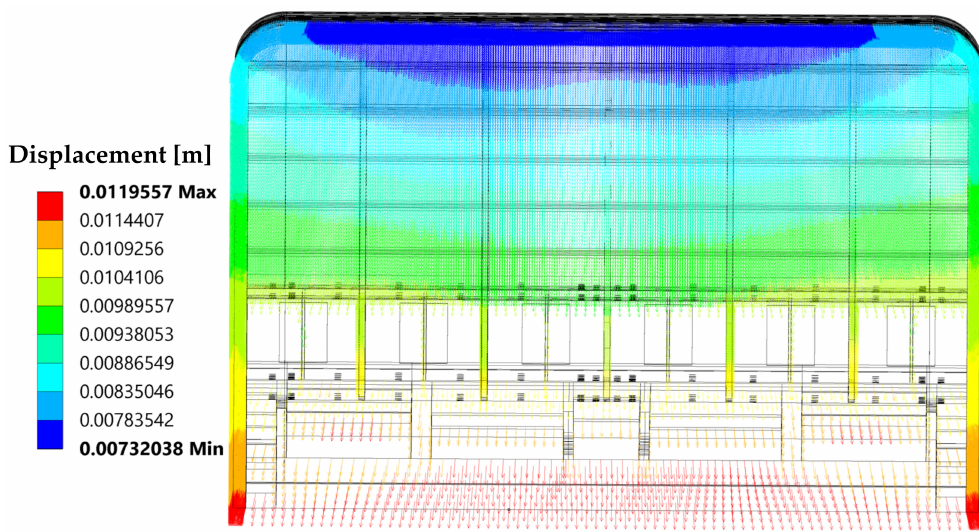
Figure 7. Displacement field applied onto the model lower surface in NO